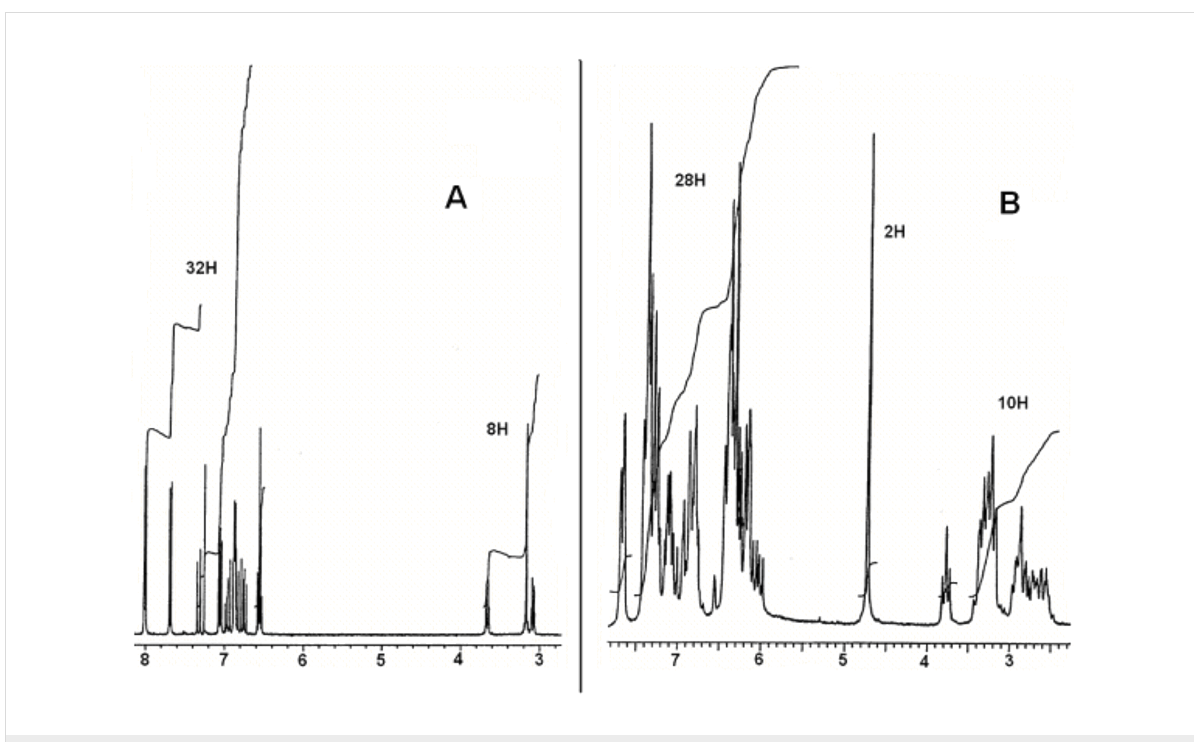
Figure 10: 1 H NMR spectra (400 MHz, CDCl3). A: Compound 2 , B: Compound 4